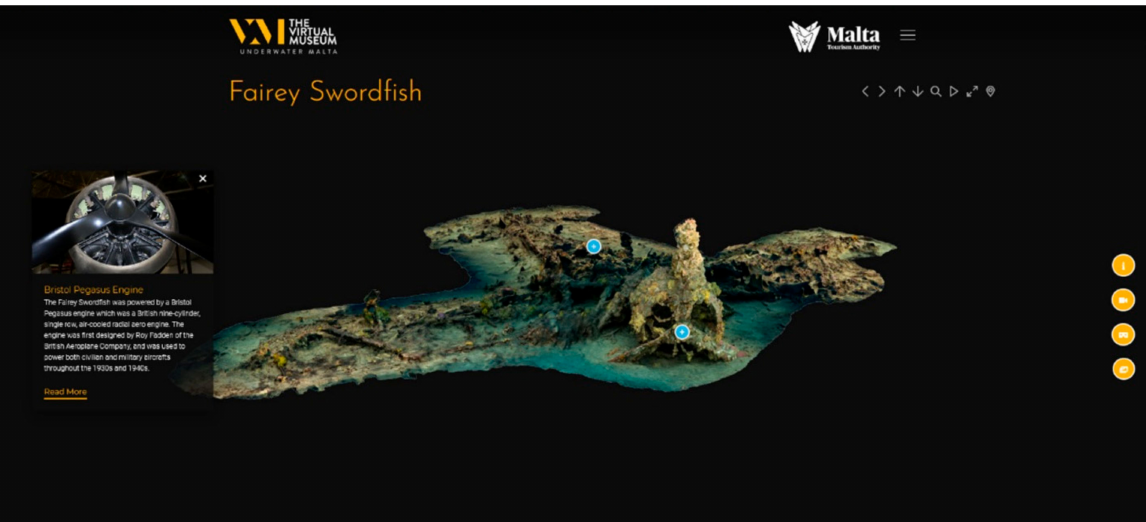
Figure 9. “Landing model” of the Fairey Swordfish wreck site, including an